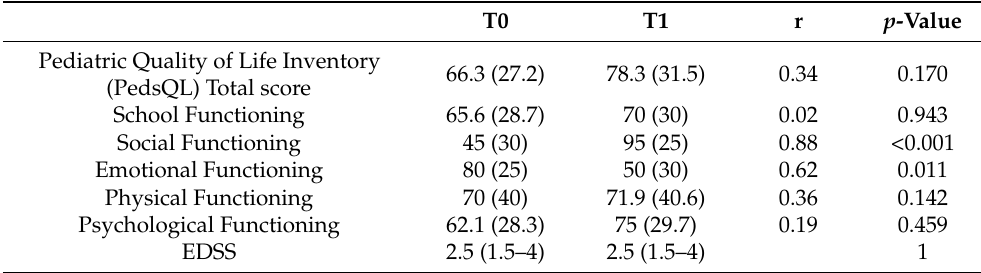
Table 2. Longitudinal changes in clinical scales. PedsQL: Pediatric Quality of Life Inventory; EDSS: Expanded Disability Status